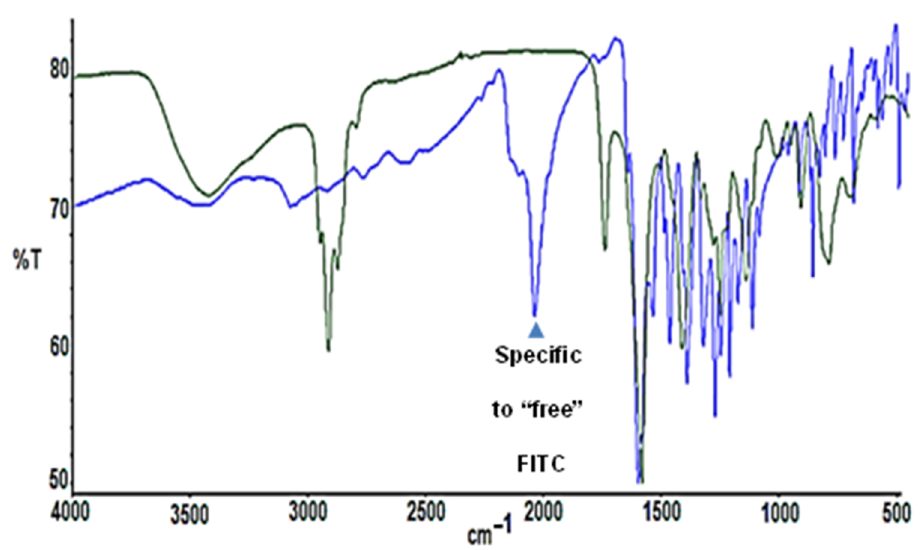
Figure 5. IR spectrum of FITC (blue) and compound IV (green).